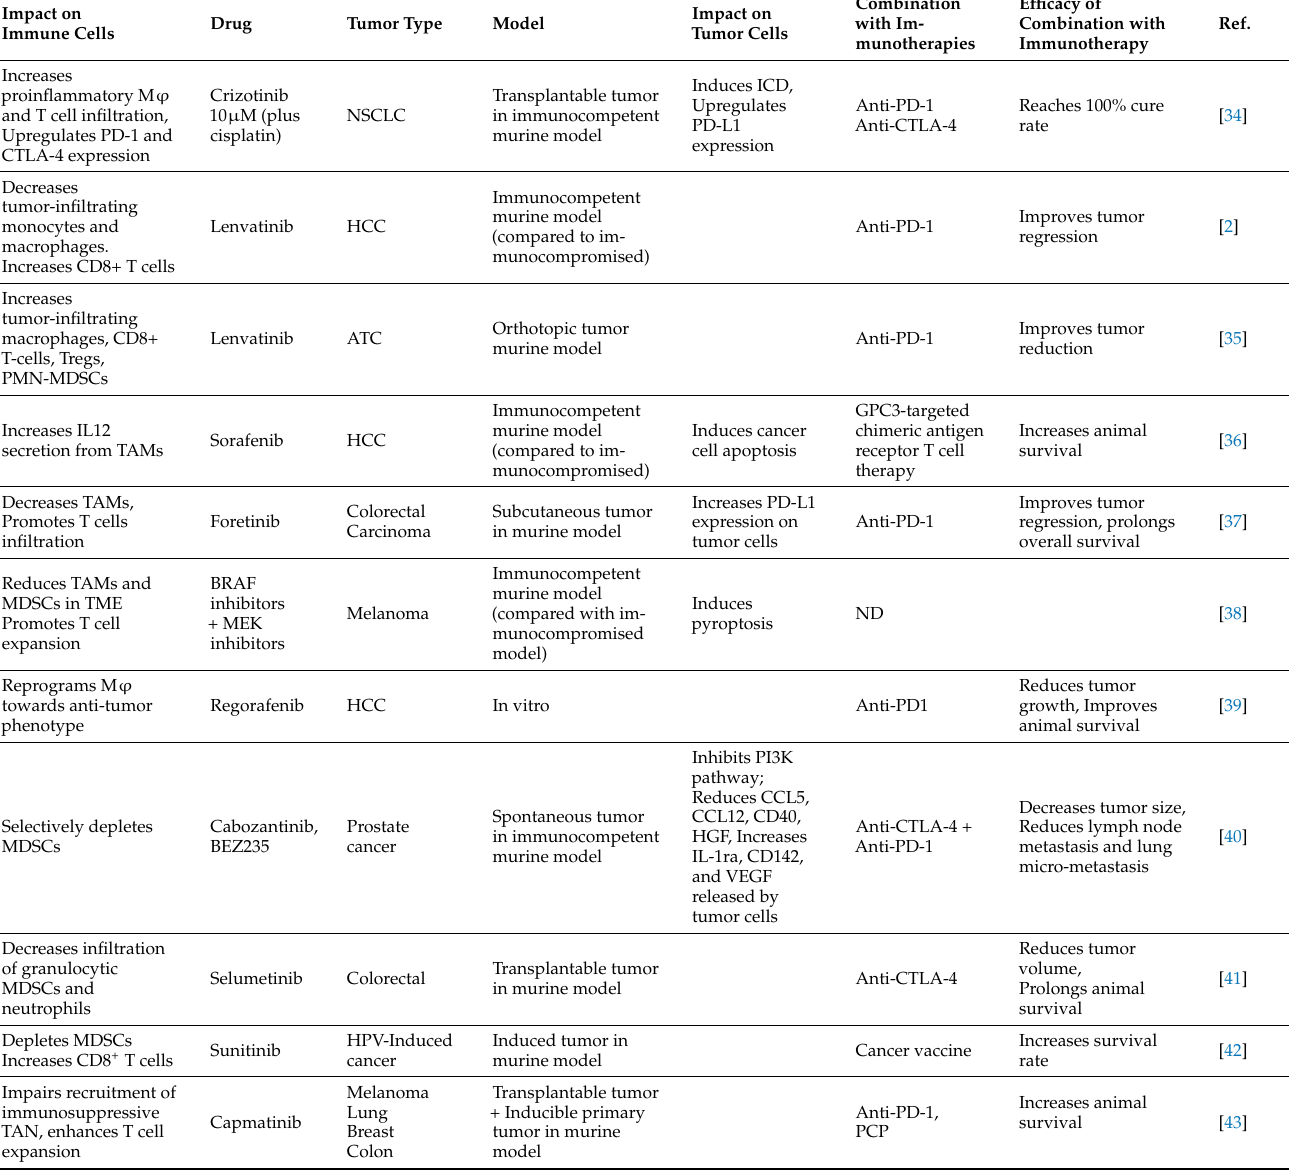
Table 2. Immunological effects of kinase inhibitors in preclinical